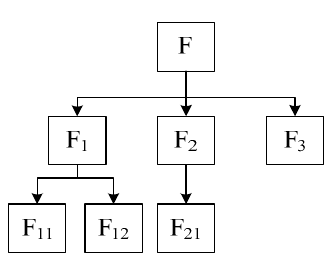
Figure 2. Functional decomposition [52].